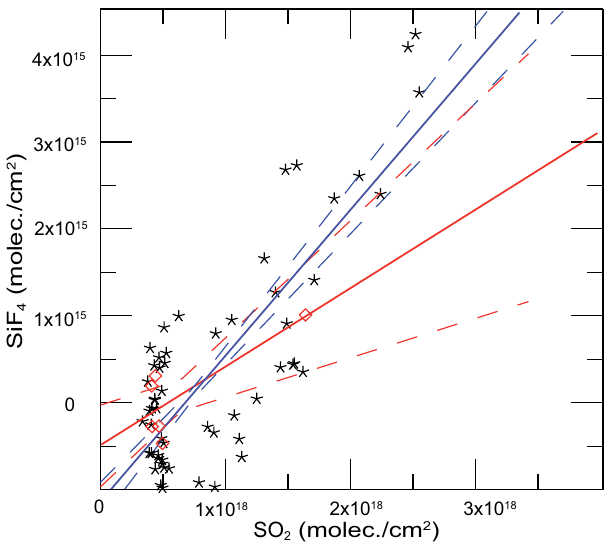
Fig. 8. Slant columns of SiF 4 retrieved from lunar absorption spec- tra (black) plotted together with SiF 4 from thermal emission spectra at 0.5cm − 1 (red) against the corresponding SO 2 columns. Temper- ature of the plume is estimated to be 266K (see, Fig. 7 and text). The molecule ratios are calculated from the linear fit and its error is indicated by the 95% confidence interval.